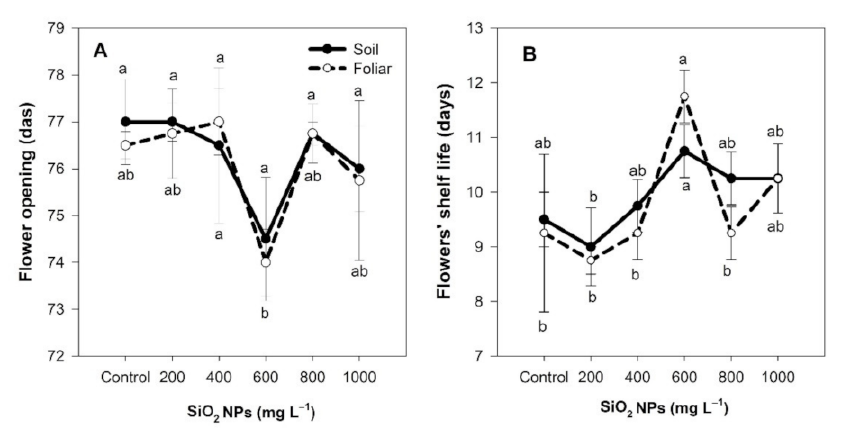
Figure 2. Effect of the application of SiO 2 NPs on the opening of the flower bud ( A ) and the flowers’ shelf life ( B ). Different letters indicate significant differences according to Fisher’s least significant difference test ( p ≤ 0.05). das, days after sowing; days, the time (in days) for which the flowers were of good